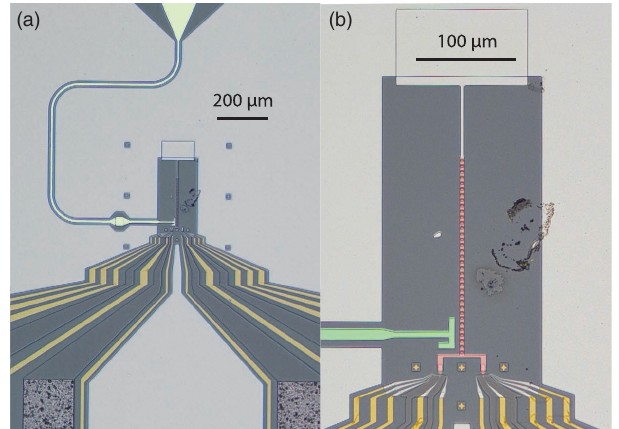
FIG. 5. Overview images of the device with only the drive line (green)andSQUID array resonator (red)false colored. (a) Overview optical image of the device, showing at the top the launcher of the drive line and its waveguide (green). At the bottom, the gate lines (yellow) are visible. The two squares at the bottom left and right are the Ohmic contacts to the 2DEG. (b) Enlarged view of